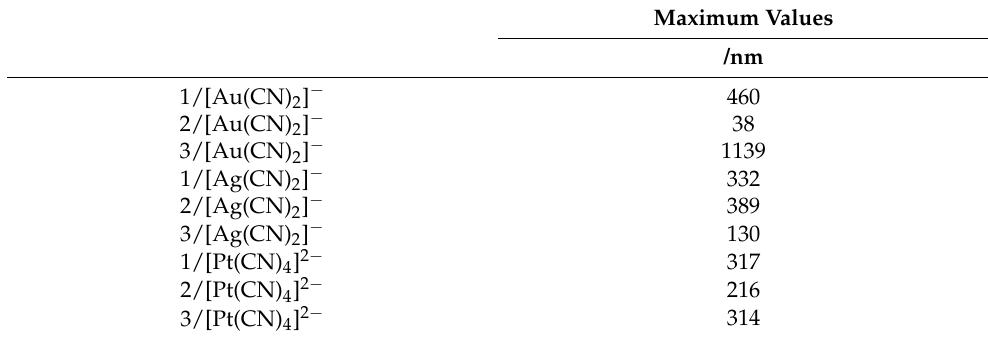
Figure 6. Dynamic light scattering results for hybrids of ( a ) [Au(CN) 2 ] − , ( b ) [Ag(CN) 2 ] − , and ( c ) [Pt(CN) 4 ] 2 − with diblock copolypeptide amphiphiles 1–3, where [Au(CN) 2 ] − = 3.5 mM, [Ag(CN) 2 ] − = 5.0 mM, and [Pt(CN) 4 ] 2 − = 2.7 mM. Table 2. Maximum values in the volume-based size distributions presented in dynamic light scattering results.